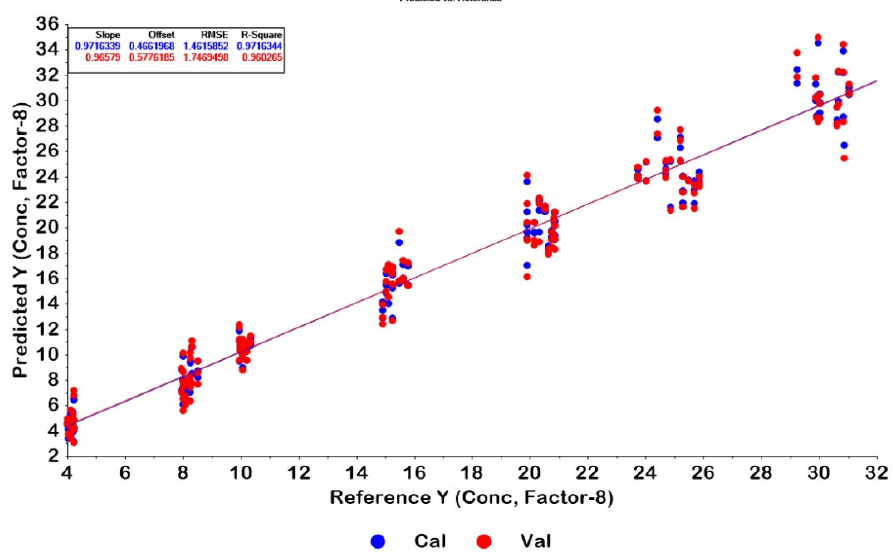
Figure 2. Plots of calibration and cross-validation of the optimum model for tablets. Calibration and cross-validation samples are in agreement, indicating that the data are appreciated modelled, the closer the slope is to 1, R 2 of model (R 2 calibration) and R 2 validation are close together indicating a good fit of model and prediction ability for future samples.